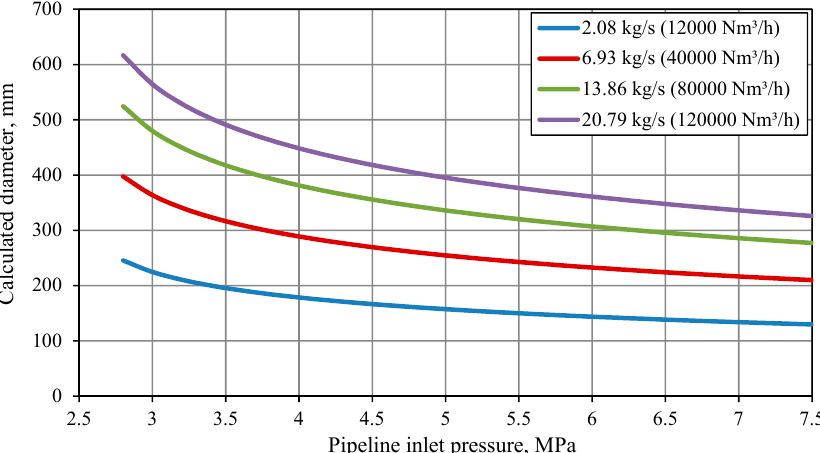
Figure 5. Diameter calculation for methane–hydrogen (15%) mixture pipeline as a function of pipeline inlet pressure.